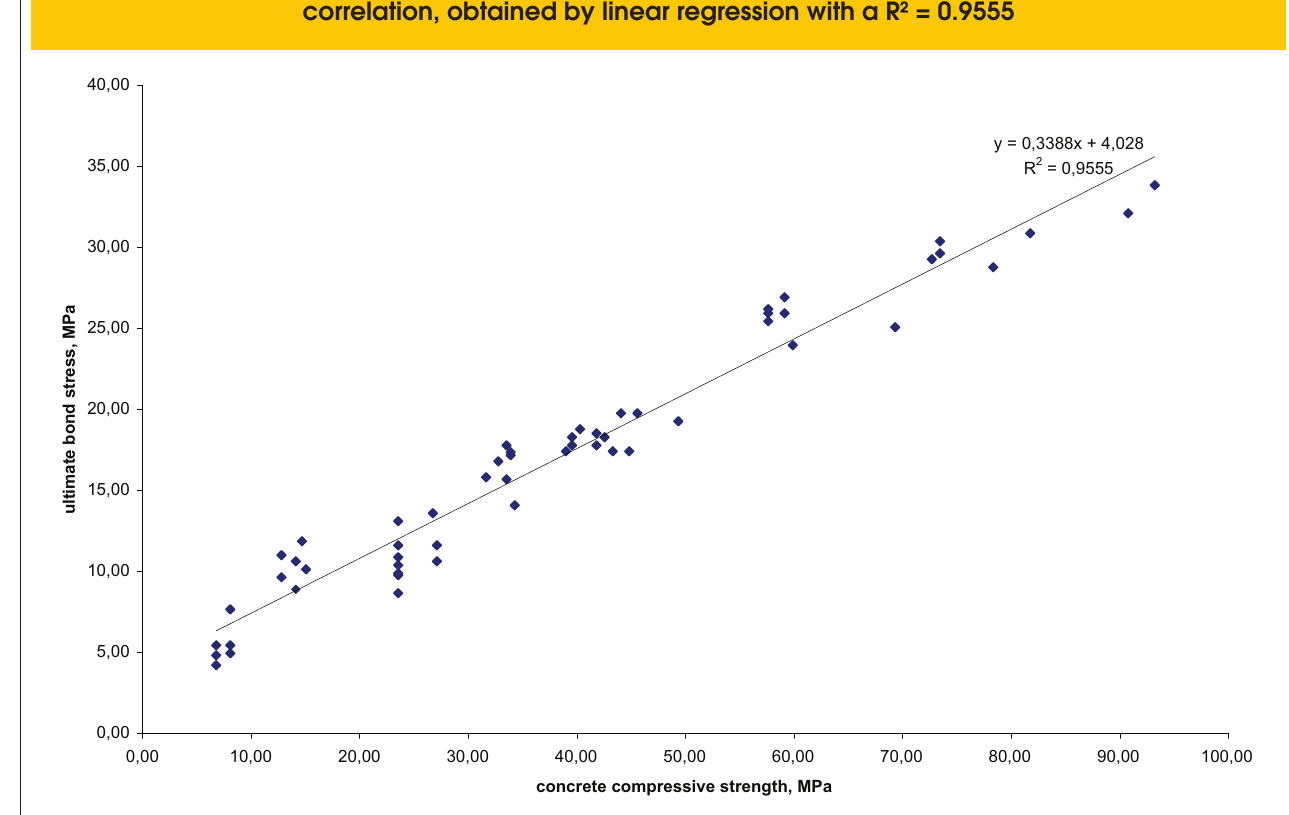
Figura 7 – Correlation line between ultimate bond stress and concrete compressive strength correlation, obtained by linear regression with a R² =